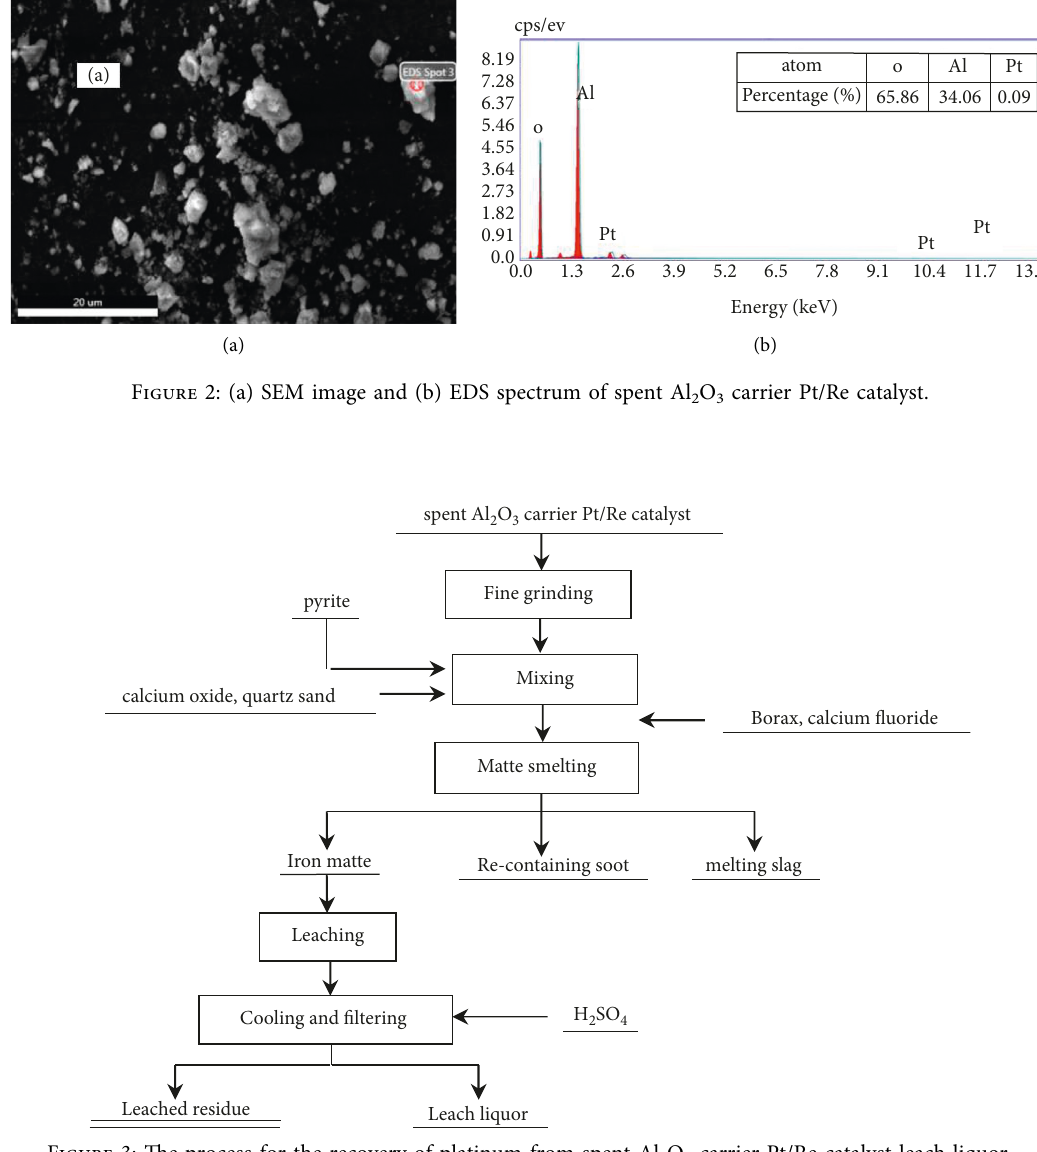
2 O 3 carrier Pt/Re catalyst leach